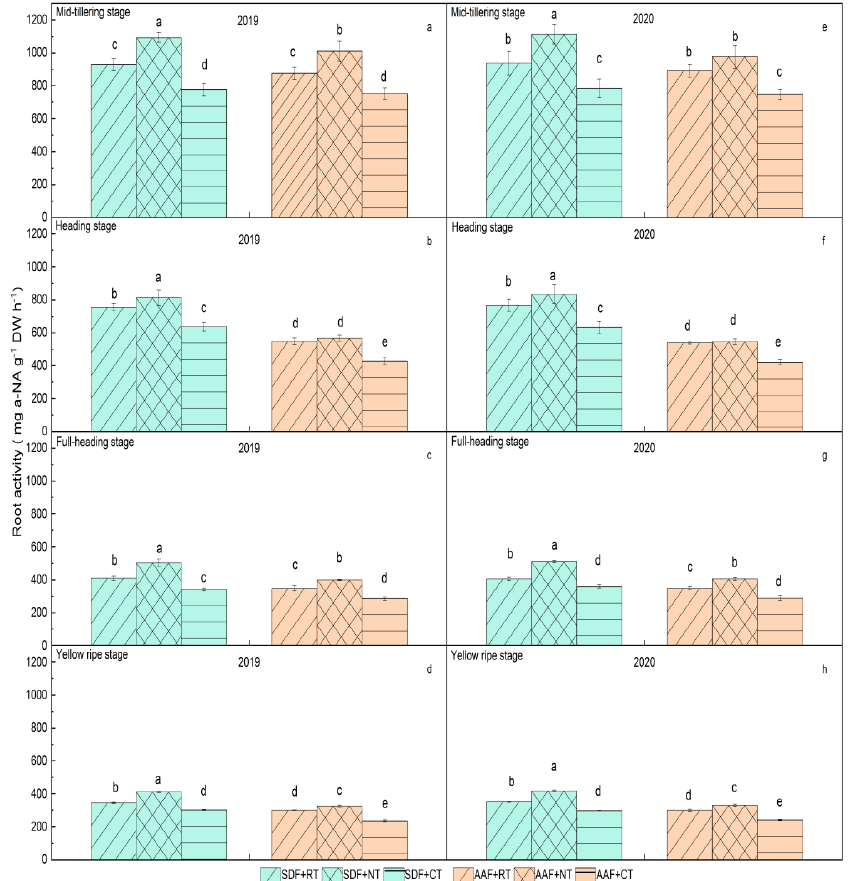
Figure 1. Root activity at different stages of rice under different tillage and fertilization treatments. ( a – d ) represent the root activity in mid-tillering stage, heading stage, full-heading stage and yellow ripe stage in 2019, respectively. ( e − h ) represent the root activity in mid-tillering stage, heading stage, full-heading stage, and yellow ripe stage in 2020, respectively. SDF+RT: Side Deep Fertilizing and Reduced Tillage. SDF+NT: Side Deep Fertilizing and No Tillage. SDF+CT: Side Deep Fertilizing and Conventional Tillage. AAF+RT: Artificially Applying Fertilizer and Reduced Tillage. AAF+NT: Artificially Applying Fertilizer and No Tillage. AAF+CT: Artificially Applying Fertilizer and Conventional Tillage. Different lowercase letters marked on the histogram mean significant differences among treatments at the 5% level according to Duncan’s multiple-range test (0.05) (similarly hereinafter).